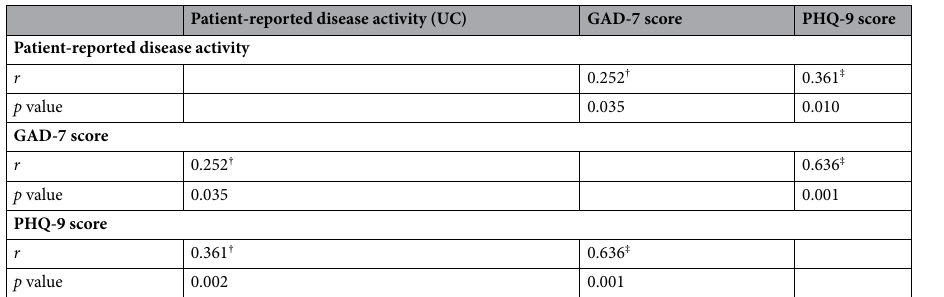
Table 3. Correlations between patient-reported disease activity, anxiety and depressive symptoms as categorical variables among UC Patients (Spearman’s rho test). UC ulcerative colitis, GAD-7 generalized anxiety disorder-7, PHQ-9 patient health questionnaire-9. † Correlation is significant at the 0.05 level (2-tailed). ‡ Correlation is significant at the 0.01 level